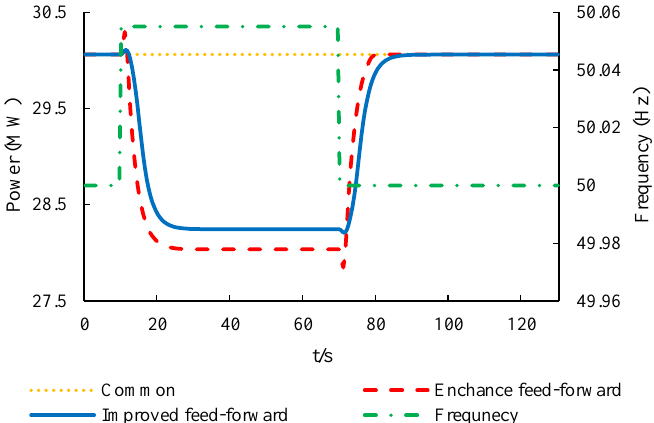
Figure 18. The blade angle curve of PFC with common frequency dead zone, enhanced frequency dead zone with feed-forward control, and improved frequency dead zone with feed-forward control.